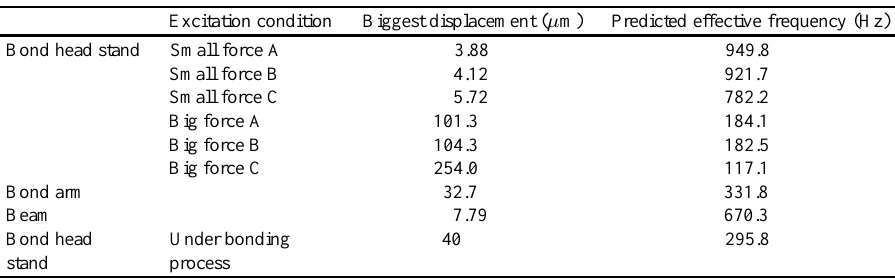
Fig. 16. Measuring points in x -, y -, and z -direction on the bond head stand and base. Table 6 Predicted effective